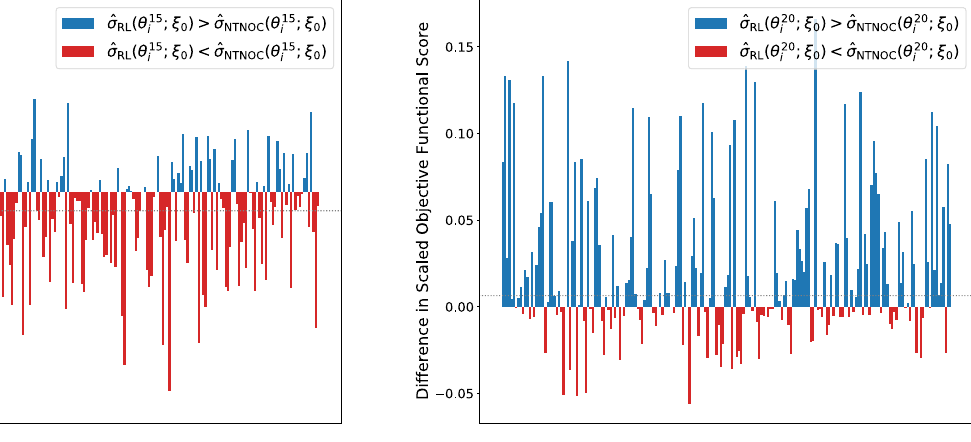
(b) Difference in scaled objective functional score for virtual patients at 20% perturbation strength..